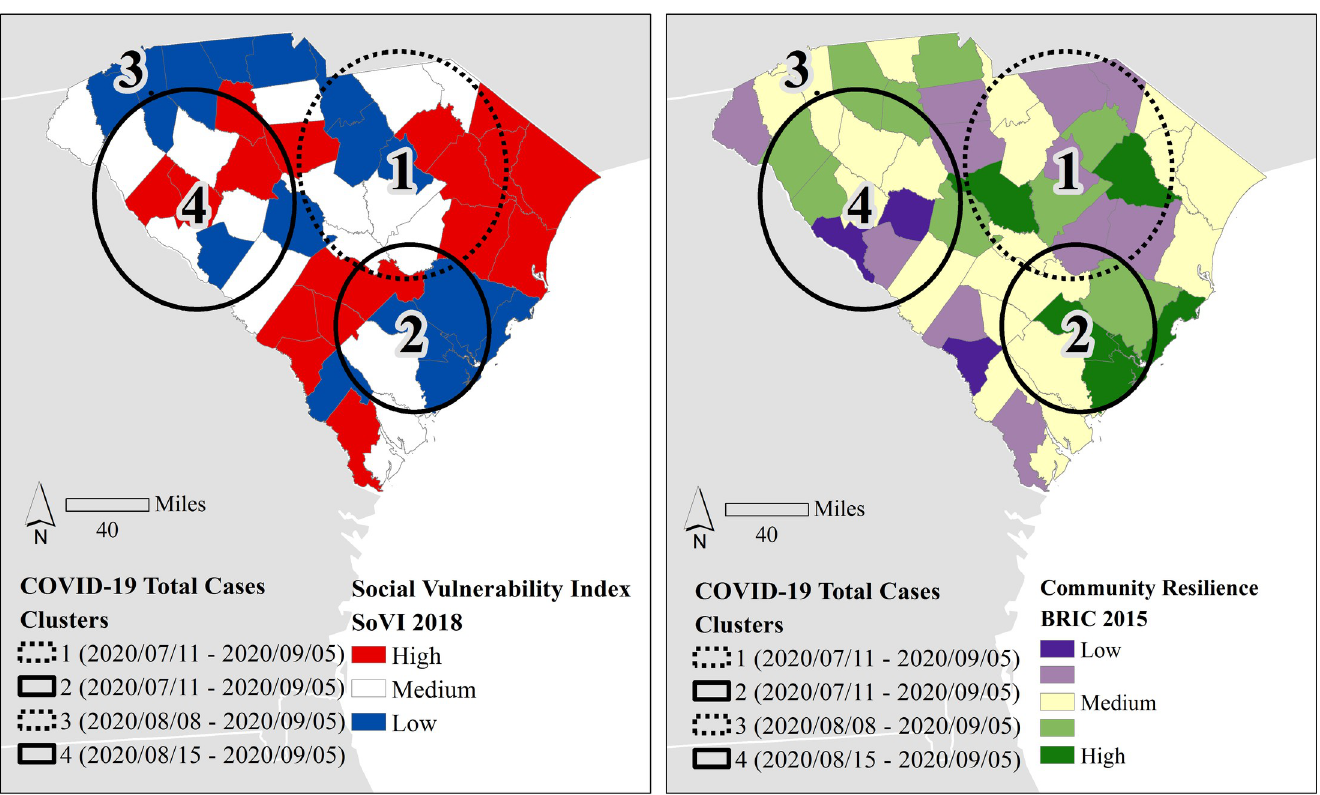
Fig 5. Space-time analysis clustering results for cumulative total cases, March 1 st through September 5 th (epi weeks 10–36). Using the county’s social vulnerability (left) and community resilience (right) as backdrops, the straight lines refer to high clusters, and dashed lines refer to low clusters. All clusters are significant ( p < . 001) . County and state boundaries are retrieved from the U.S. Census Bureau (https://www.census.gov/geographies/mapping-files/time-series/geo/carto-boundary-file. html).